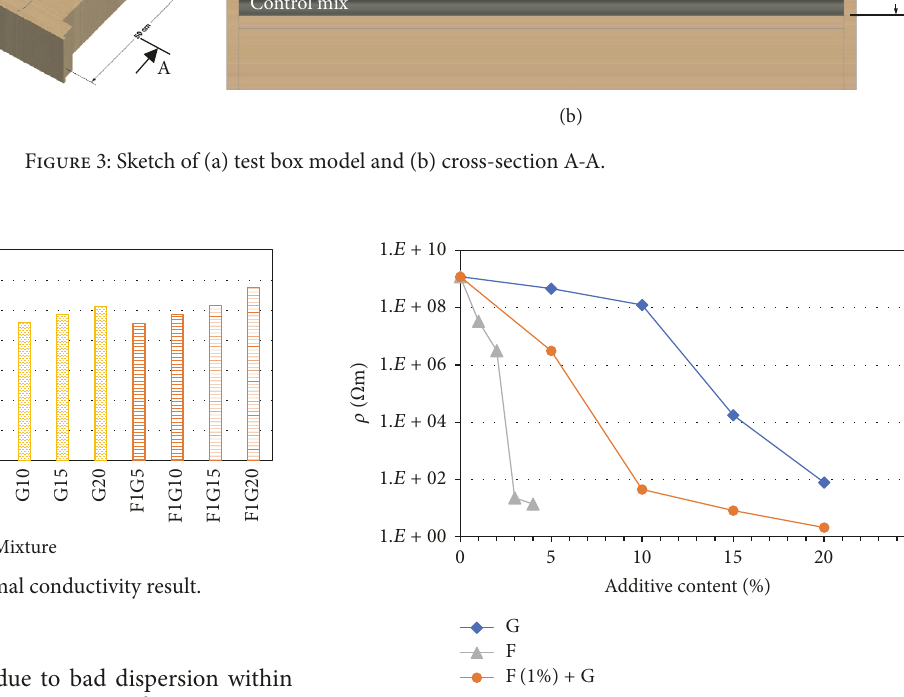
Table 2, along with the coefficient of variation (COV), varying from 1.08 to 4.25 percent and 1.58 to 16.7 percent,